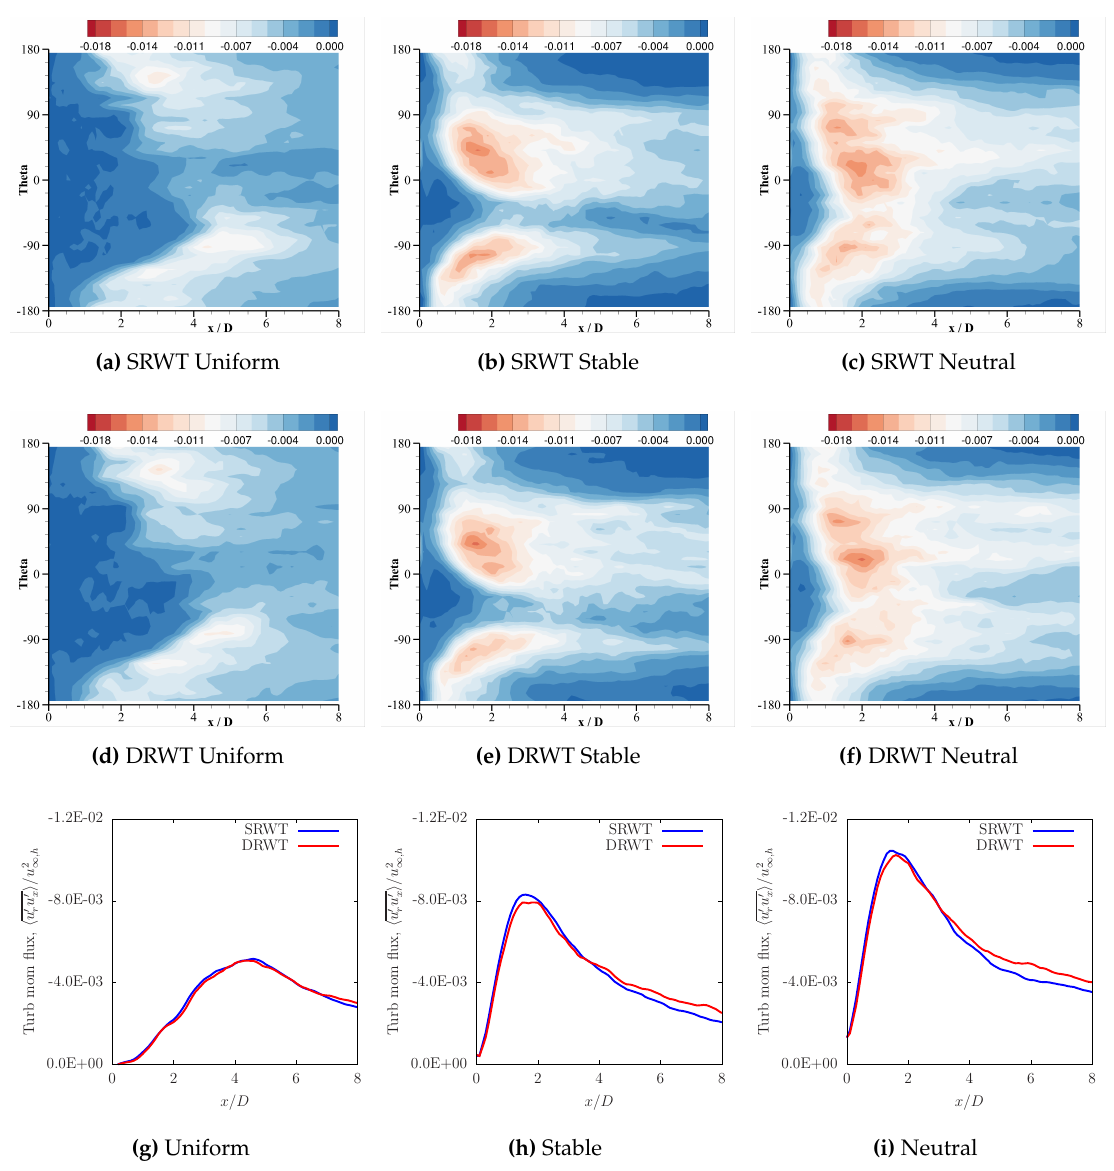
Figure 15. Radial transport of streamwise momentum into the turbine wake layer. Color contours on the cylindrical surface of Figure 14 that has been cut at θ = ± 180 ◦ and show u (cid:48) r u (cid:48) x / u 2 ∞ , h